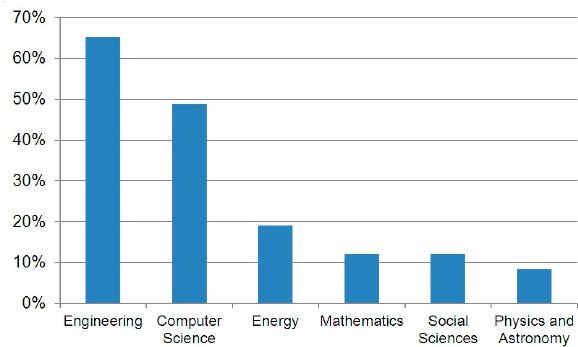
Figure 9. Distribution of surveyed papers according to their type.